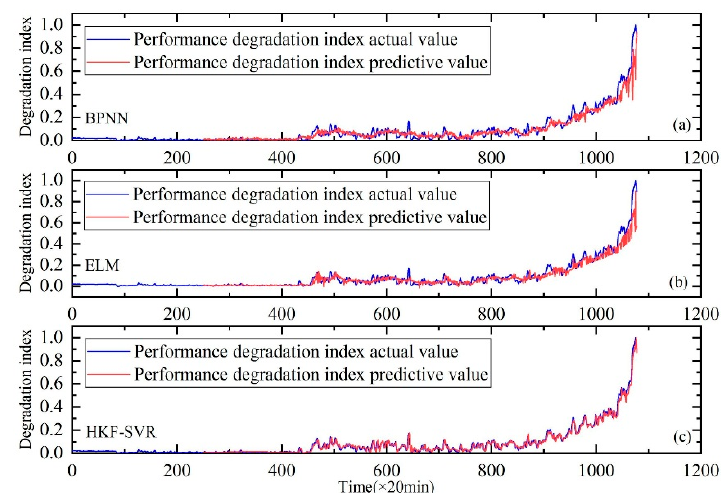
Figure 8. Performance degradation prediction of bearing 1. ( a ) is the result of BPNN, ( b ) is the result of ELM and ( c ) is the result of HKF–SVR with parameters optimized by the KH algorithm.